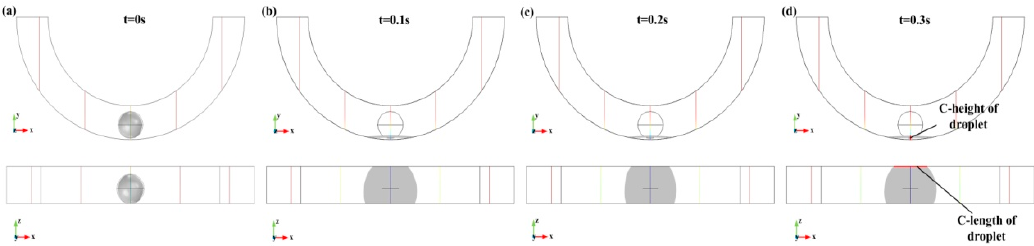
Figure 4. The images of droplet deformation after 0.3 s: ( a – d ) are the droplet deformation results with time steps of 0 s, 0.1 s, 0.2 s, and 0.3 s,